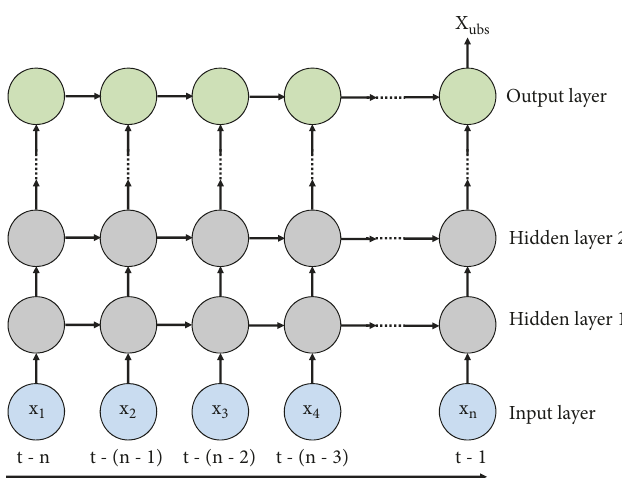
Figure 6: The architecture of the LSTM.